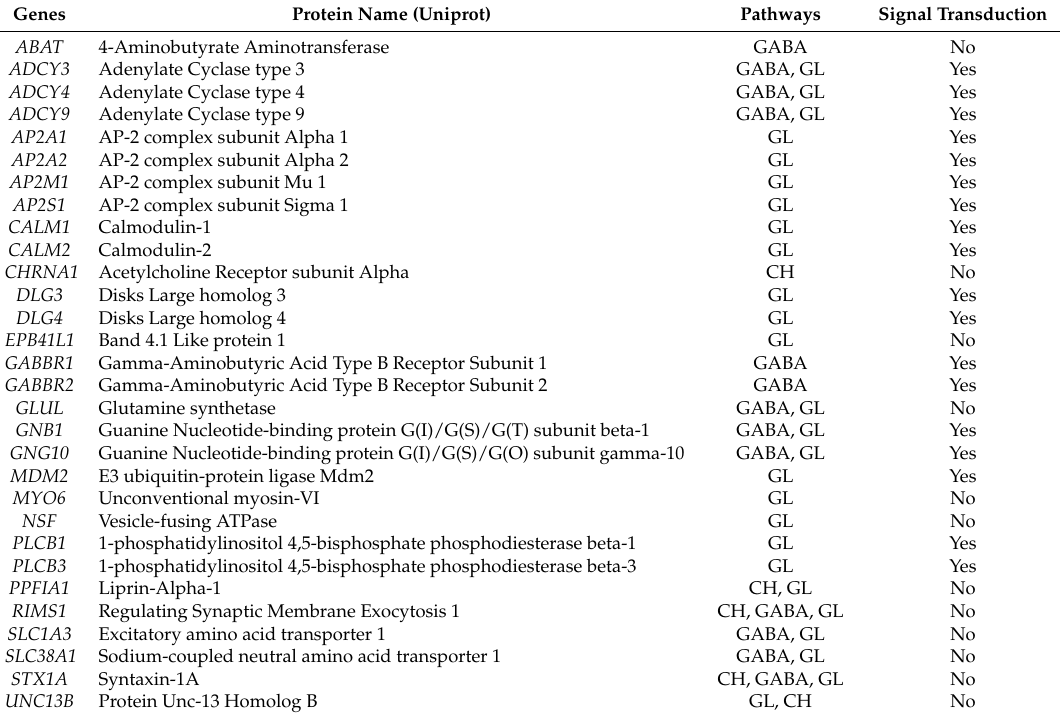
Table 1. Genes of our dataset included in Cholinergic, GABAergic, Glutamatergic REACTOME pathways.